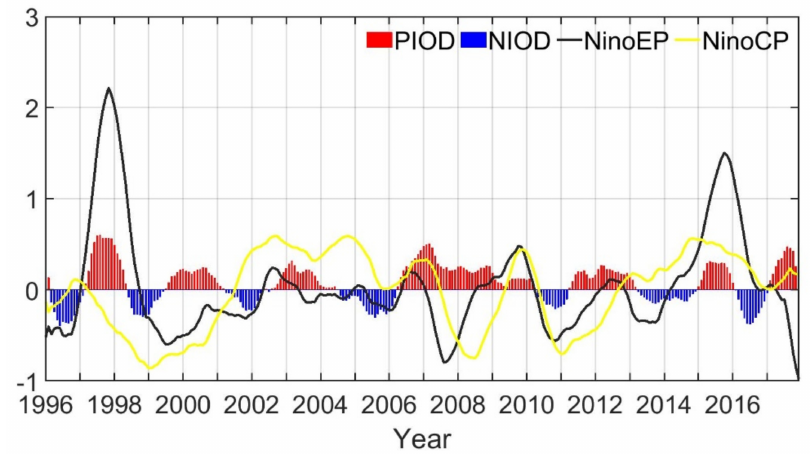
Figure 1. The interannual curves of DMI and NinoCE indexes, which were all treated with a moving average for 13